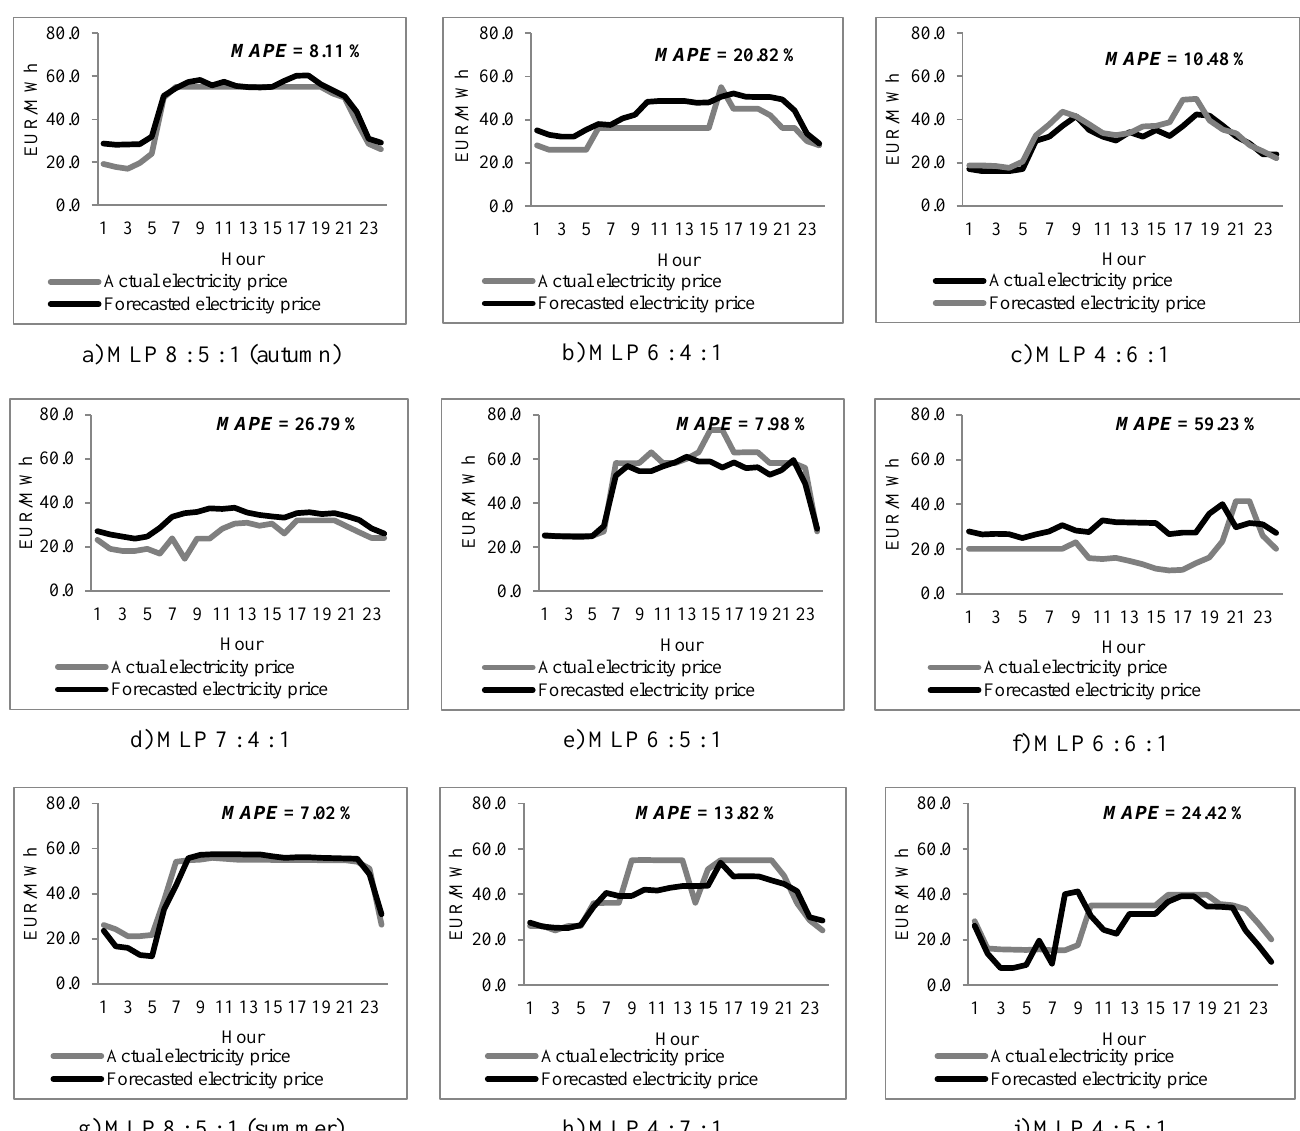
Fig. 8. Actual and forecasted (expected) electricity prices and the accuracy of the predictions subject to different models (calculations made by the